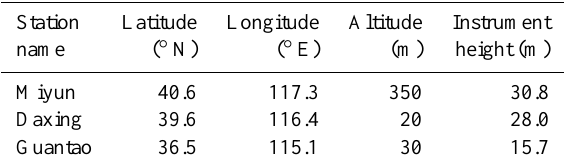
Figure 1. Spatial distribution of ground stations used for SSR re- trieval validation. The red cross marks illustrate the 44 BSRN sta- tions, the blue cross marks denote three experimental stations over the Haihe River basin in China, and the circle marks represent the 90 CMA radiation stations. Table 2. The basic information of three experimental stations over the Haihe River